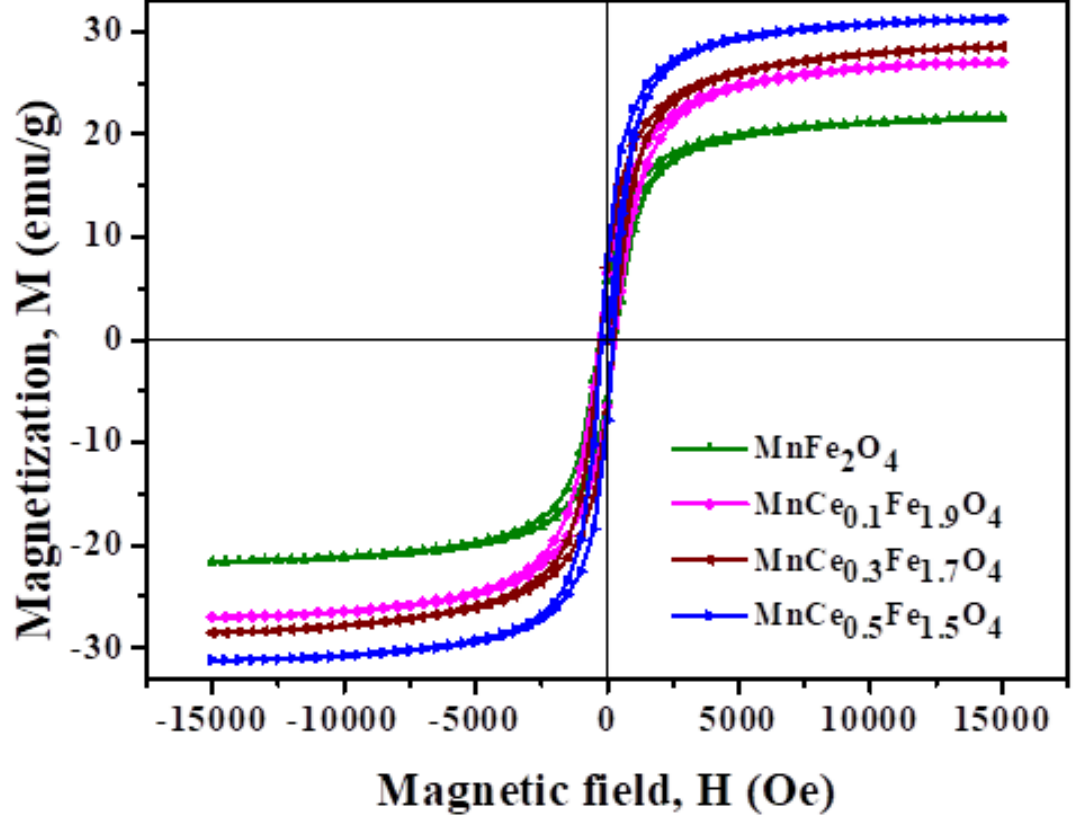
Figure 7. M–H hysteresis loops of spinel MnCe x Fe 2 − x O 4 (x = 0.0, 0.1, 0.3 and 0.5)